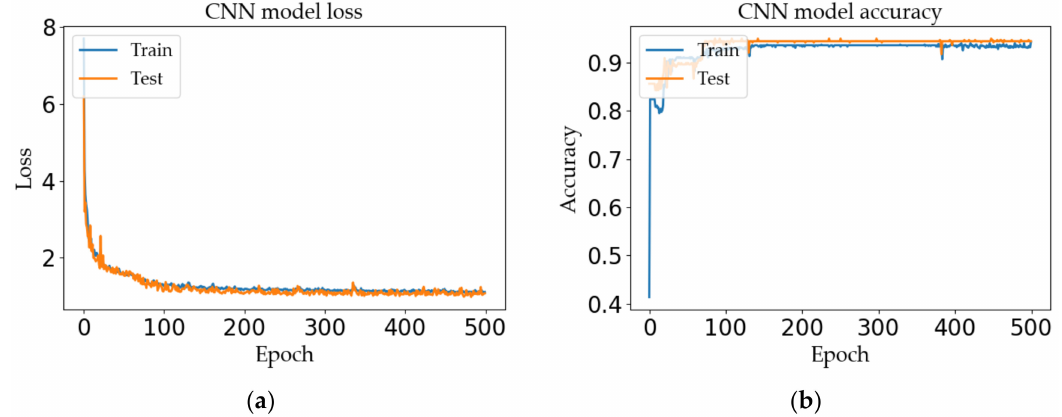
Figure 10. Performance analysis of positioning model: ( a ) loss curves and ( b ) accuracy curves.